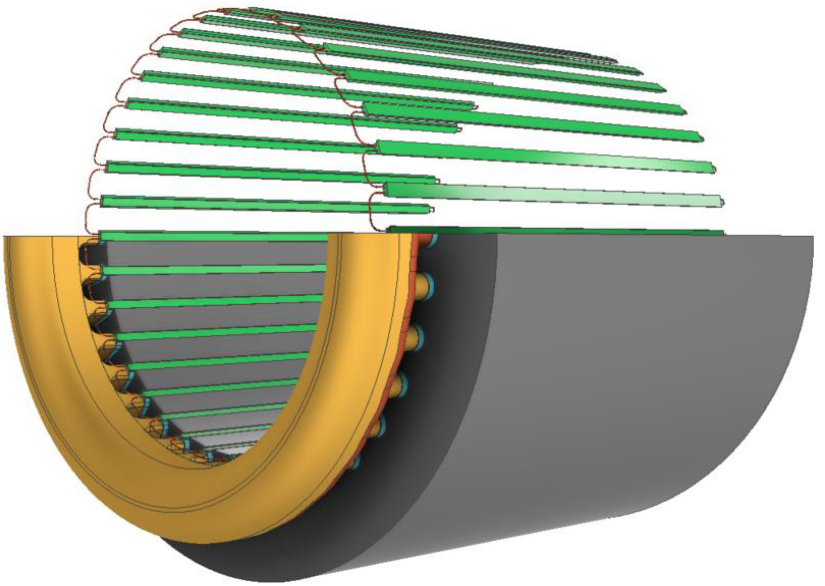
Figure 6. The concept of using the shielding winding located in the stator slot wedges.